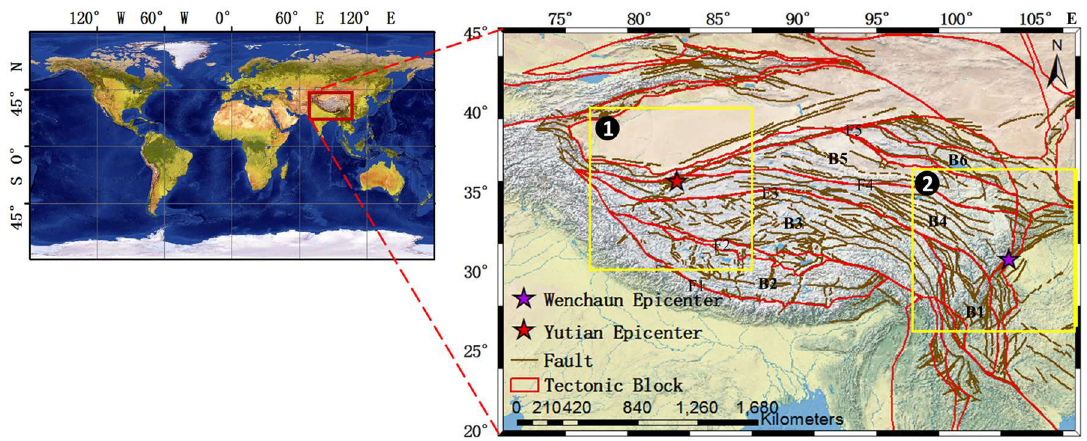
Figure 1. Tectonic blocks and fault zones in the Qinghai-Tibet Plateau. The Yellow Border 1 on the left denotes the Altyn fault region; and the Yellow Border 2 on the right is the Longmenshan fault region. The sizes of these two sub-regions of the study area were both 10 ° × 10 ° .